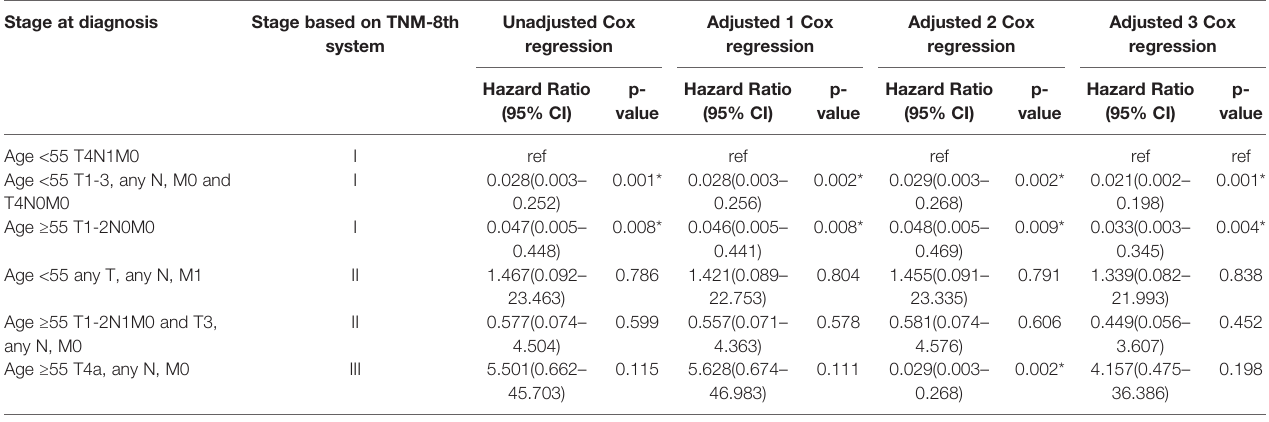
TABLE 5 | Hazard ratios of AJCC Cancer Staging (8th Edition) for cancer-speci fi c